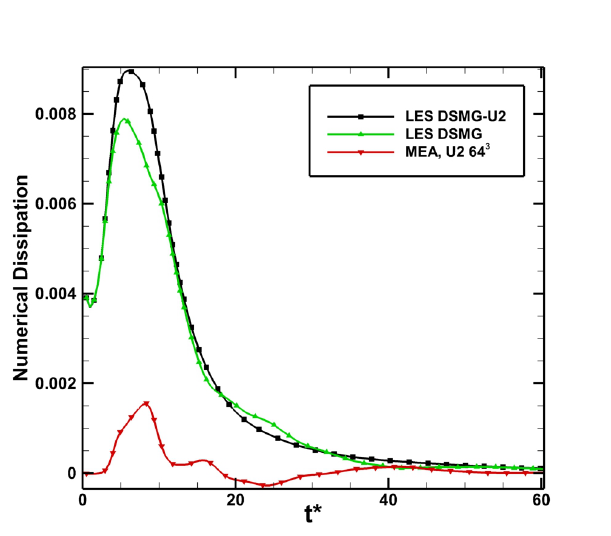
Figure 8. Dissipation of the DSMG model obtained by subtracting the truncation error of the second-order upwind scheme (MEA U2) from the total kinetic energy dissipation rate obtained on a 64 3